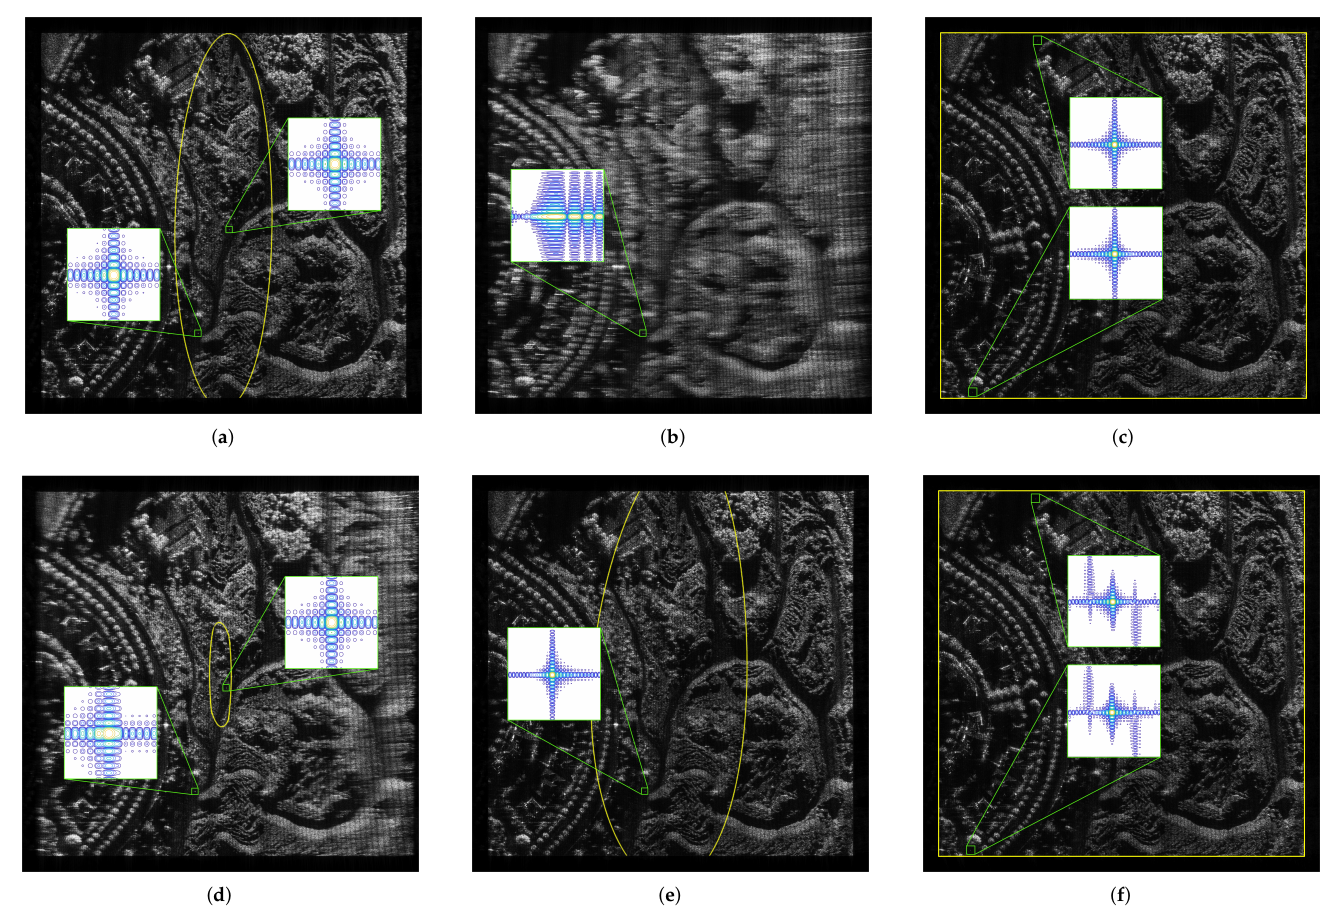
Figure 27. Extended-target images of different measurable error with coefficients ( a ) A 1 = A 2 = A 3 = 0.05 (small-error) and ( d ) A 1 = A 2 = A 3 = 1 (large-error). Extended-target images of unmeasurable error with coefficients A 1 = A 2 = A 3 = 0.02 include ( b ) direct imaging result and ( e ) autofocus imaging result. Extended-target images with segment-varying parameters adjusted every ( c ) 100 pulses and ( f ) 1000